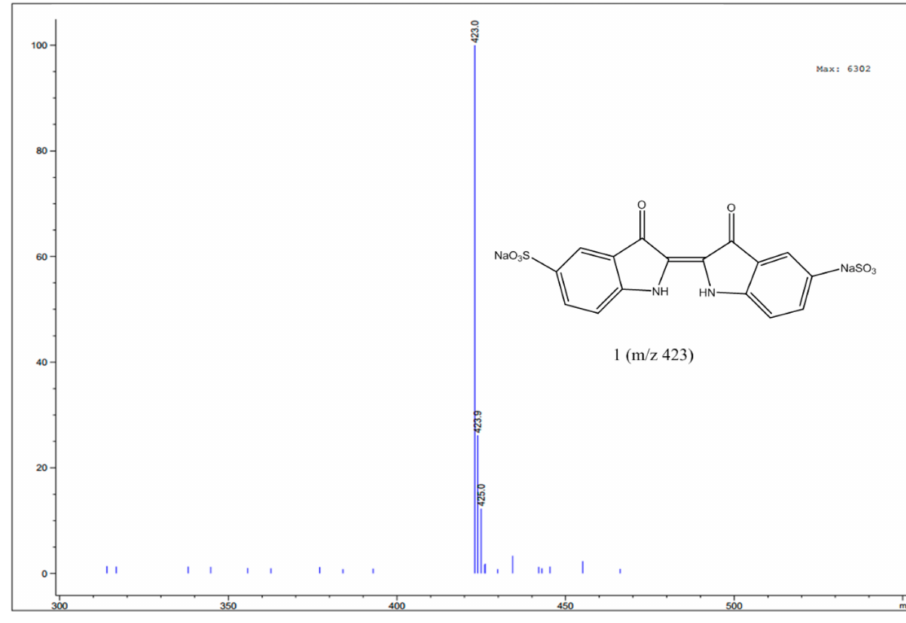
Figure 8. LC-MS analysis of initial indigo carmine